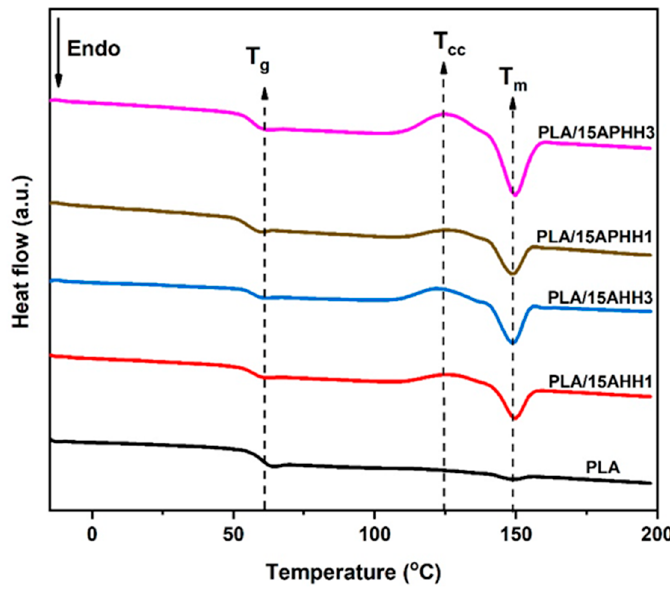
Figure 6. DSC thermograms of PLA and its biocomposites for 15 wt. % filler loading. Table 5. DSC data corresponding to PLA and its biocomposites.